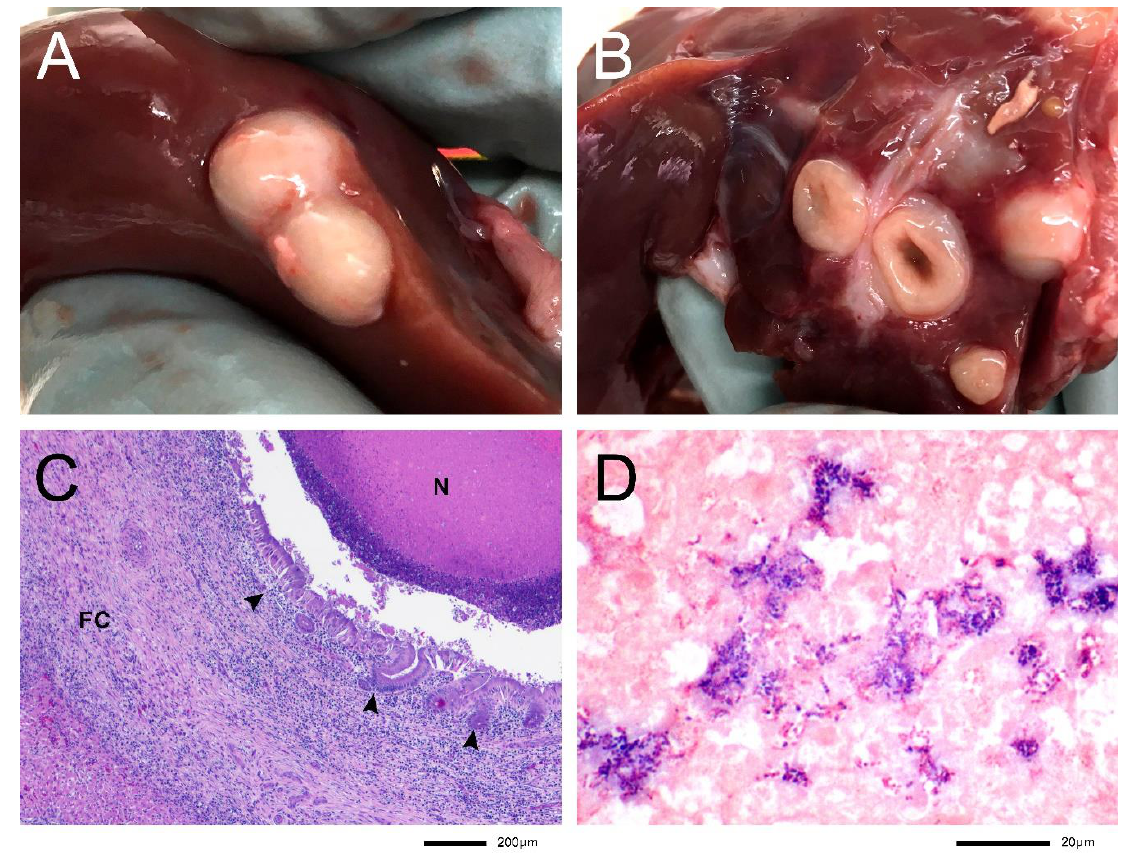
Figure 2. Sheep liver from which Streptococcus ruminantium was isolated, strain CCGMV928. ( A ) White nodular lesions on a liver surface measuring 0.5 to 2 cm in diameter. ( B ) Detail of a sectioned intraparenchymal nodule. ( C ) H&E staining showing a necrotic core (N) surrounded by a suppurative inflammatory infiltrate and a fibrous capsule (FC). Notice the remains of the biliary epithelium (arrowheads). ( D ) Gram staining. Showing multiple coccus-shaped Gram-positive bacteria within the necrotic core.